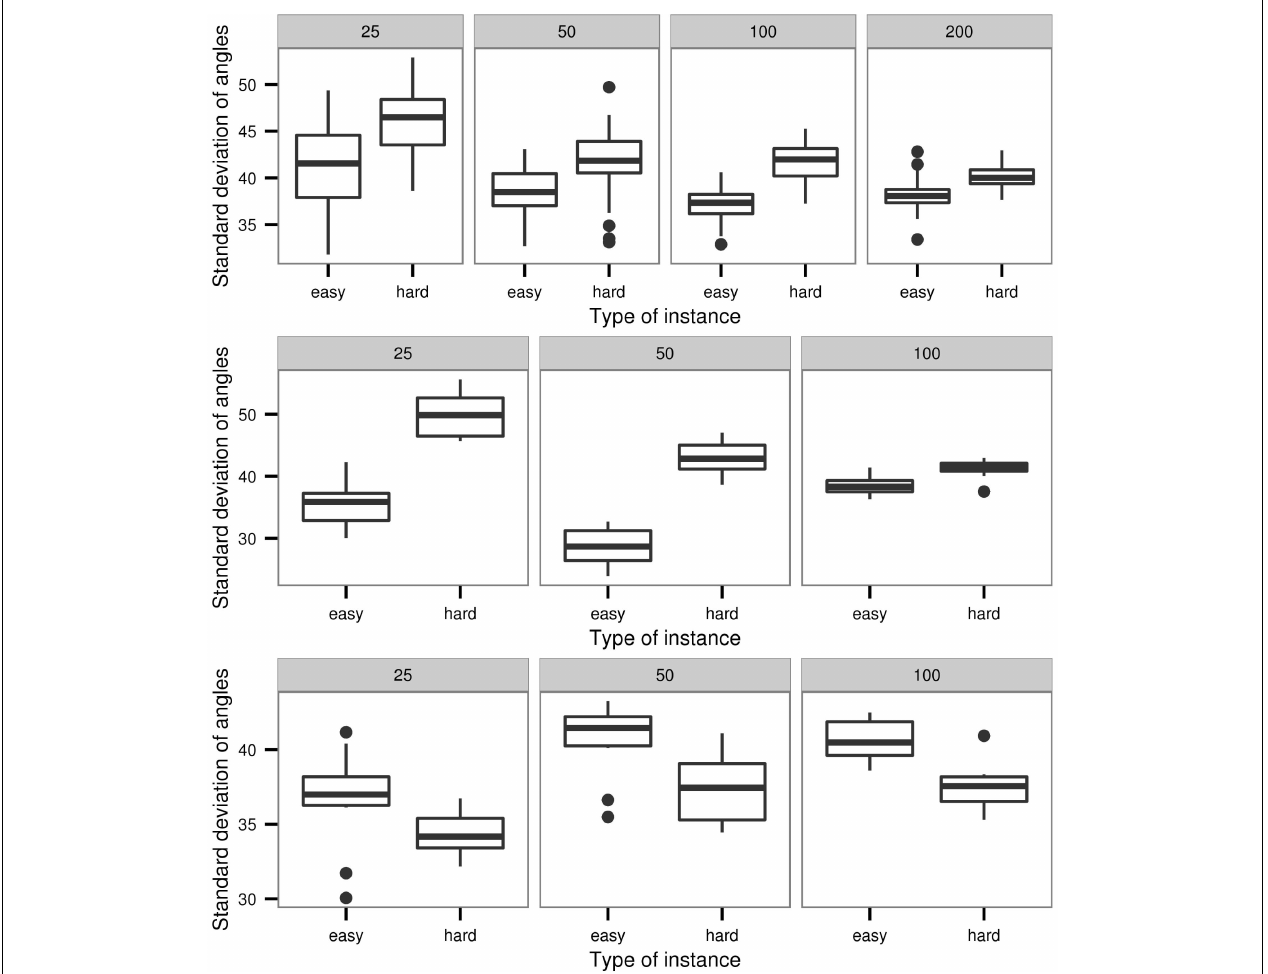
FIGURE 2 | Boxplots of the SDs of the angles between adjacent cities on the optimal tour for parameter setting 1 ( (cid:11) =1, (cid:12) =2) in top, 2 ( (cid:11) =0, (cid:12) =4) in middle and setting 3 ( (cid:11) =4, (cid:12) =0) in bottom .